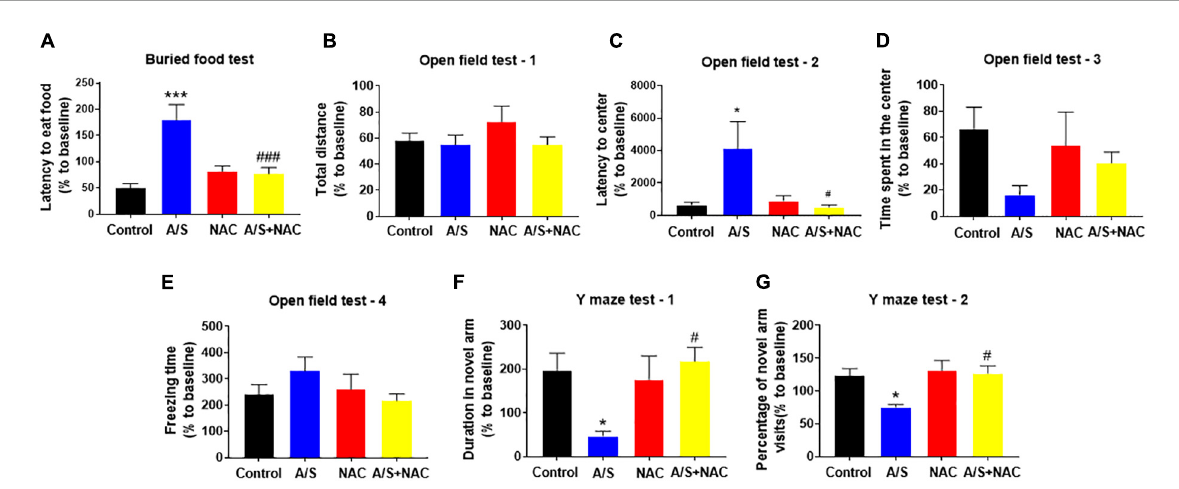
FIGURE3 Effects of ROS on anesthesia/surgery-induced delirium-like behavior in mice. Scavenging ROS alleviates anesthesia/surgery-induced delirium-like behavior. In the buried food test, CsA decreased the latency to eat food (A) in mice. In the open field test anesthesia/surgery had no influence on total distance (B) , time spent in the center (D) or freezing time (E) . CsA decreased the latency to center (C) in mice. In the Y maze test, CsA increased the duration in novel arm (F) and the percentage of novel arm visits (G) in mice with delirium-like behavior. Values